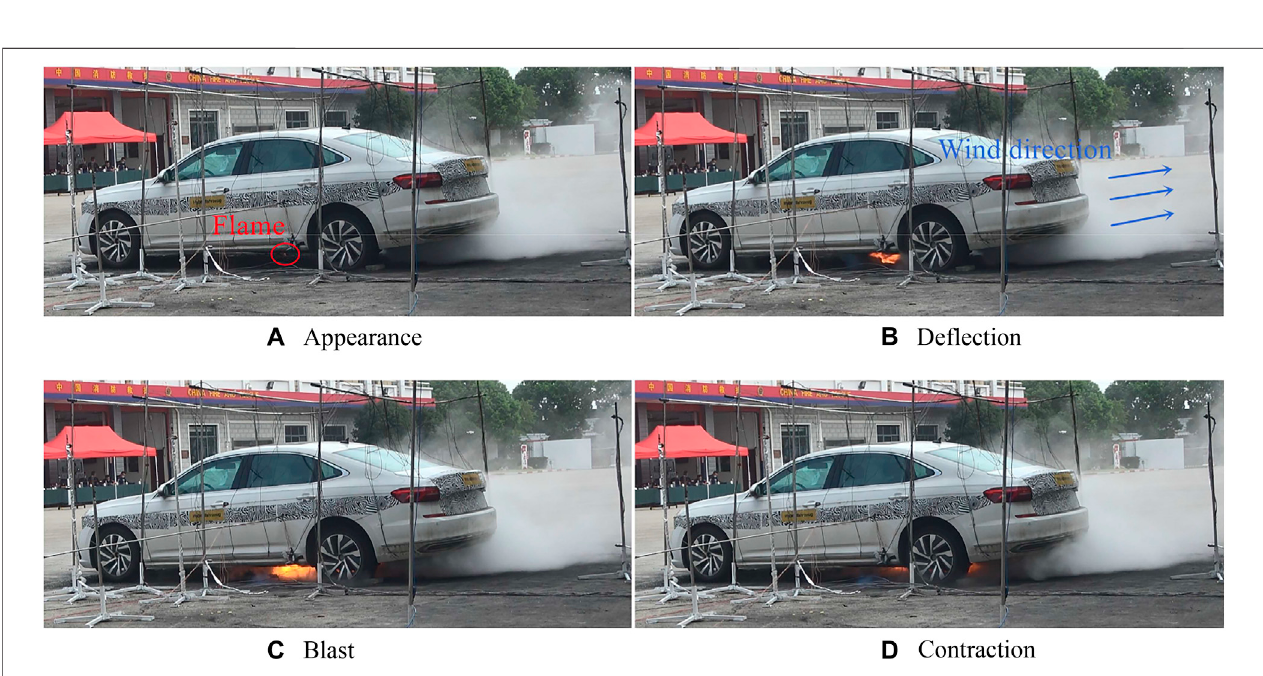
FIGURE 5 | Explosion process of PHEV B. (A) Appearance, (B) De fl ection, (C) Blast, (D) Contraction.